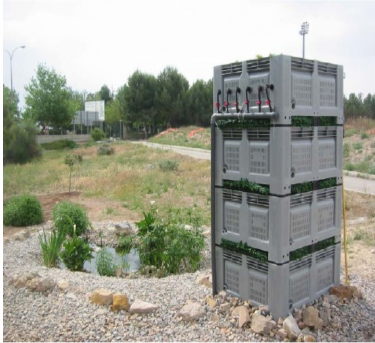
Figure 4. Picture of the pilot plant with vertical